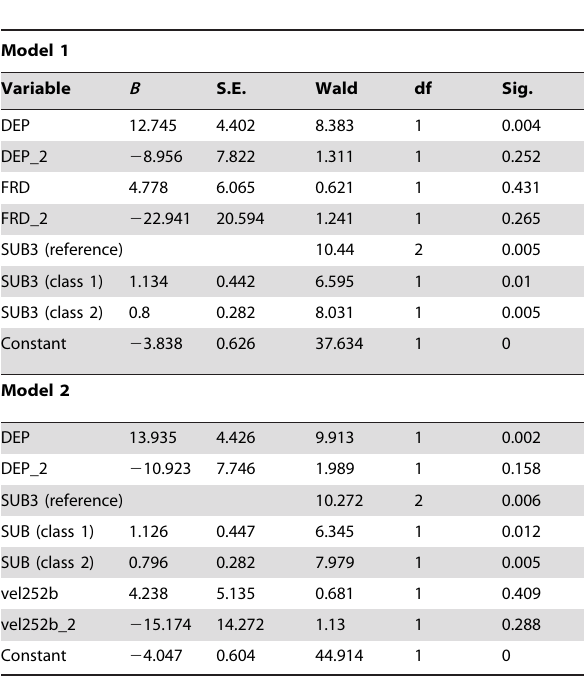
Table 3. Model parameters and coefficients for Model 1 (top) and Model 2 (bottom): outputs were obtained from multiple logistic regression on Plummer Creek, with samples collected in the spring of 2009 ( n =450; 309 absences and 141